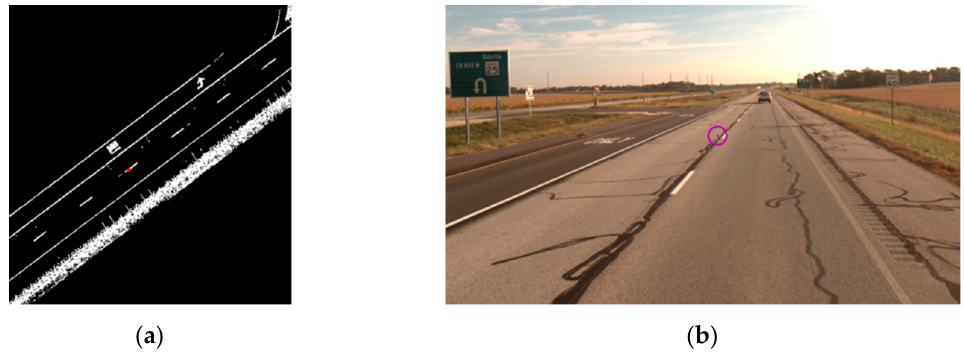
Figure 5. Illustrations of ( a ) hypothesized lane markings extracted by simple thresholding of the original intensity values and ( b ) corresponding RGB imagery in asphalt pavement area.